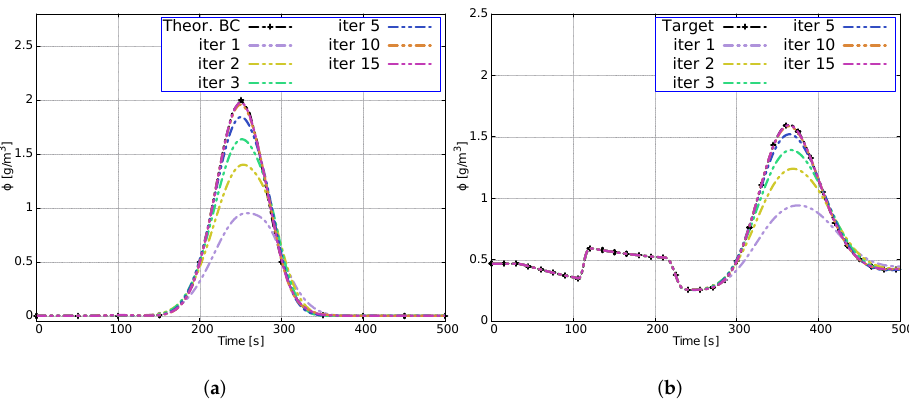
Figure 7. Case 3. Evolution of the reconstruction of the boundary condition ( a ) and evolution of the target ( b ) in some